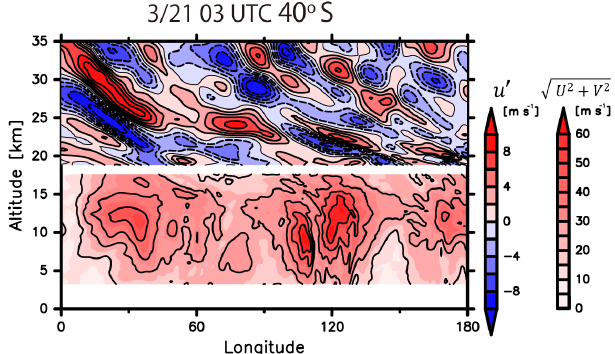
Figure 14. Snapshots of longitude–height cross sections of zonal wind components of the large-scale inertia–gravity waves (above the height of 19km, the left color bar, contour interval 2ms − 1 ) and the absolute values of the horizontal wind components (below the height of 18km, the right color bar, contour interval 10ms − 1 ) at 03:00UTC, 21 March, at 40 ◦ S. The data are from the NICAM simulation.